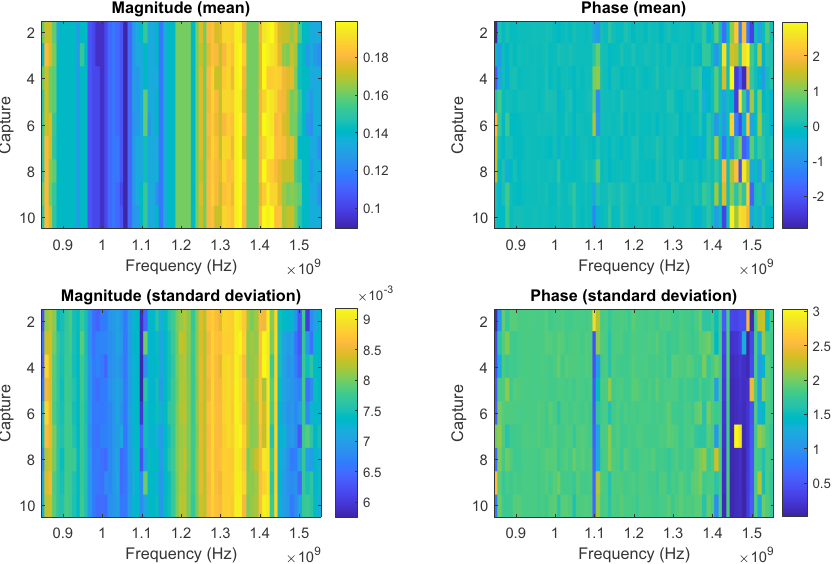
Figure 9. The mean ( top ) and standard deviation ( bottom ) of the frames in the captures of the configuration AIR, both for magnitude ( left ) and phase ( right ). The first capture was omitted because it was always corrupted by errors at the start of the measurement.